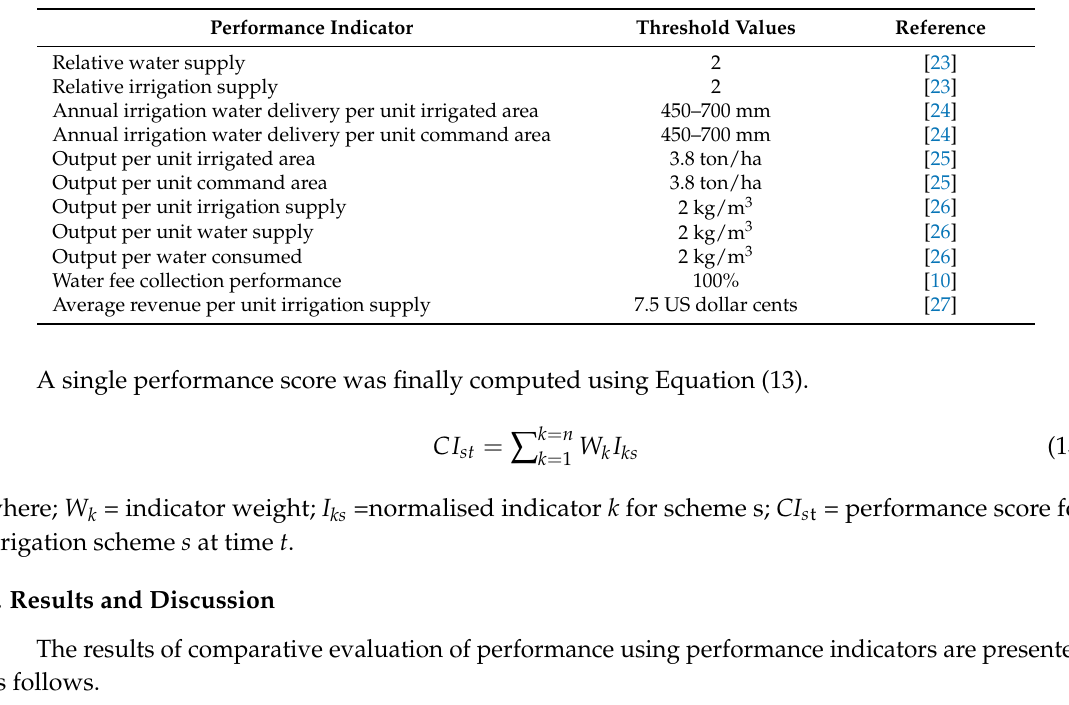
Table 5. Indicative threshold